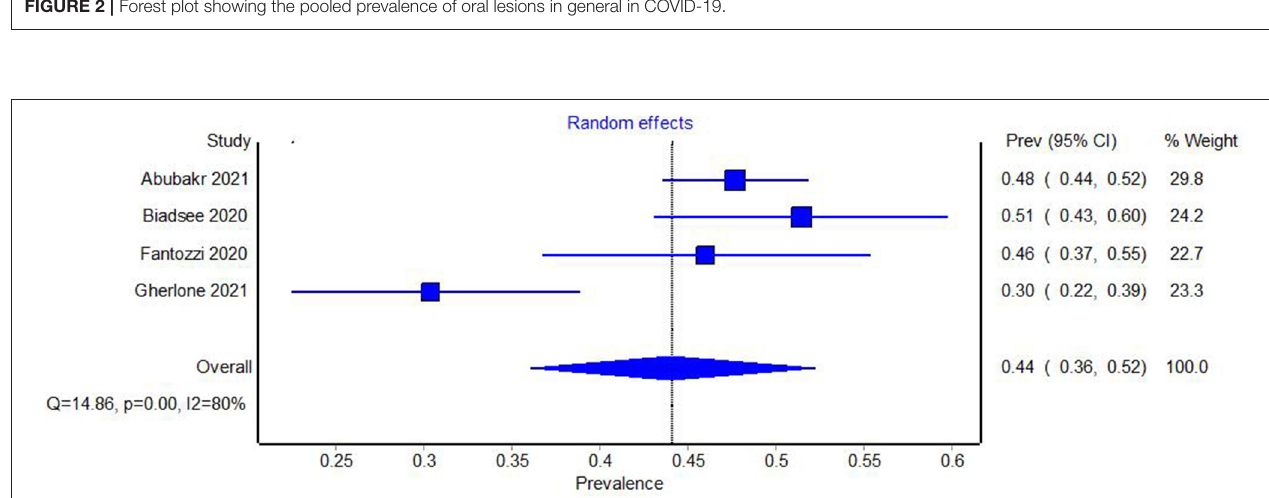
FIGURE 2 | Forest plot showing the pooled prevalence of oral lesions in general in COVID-19.